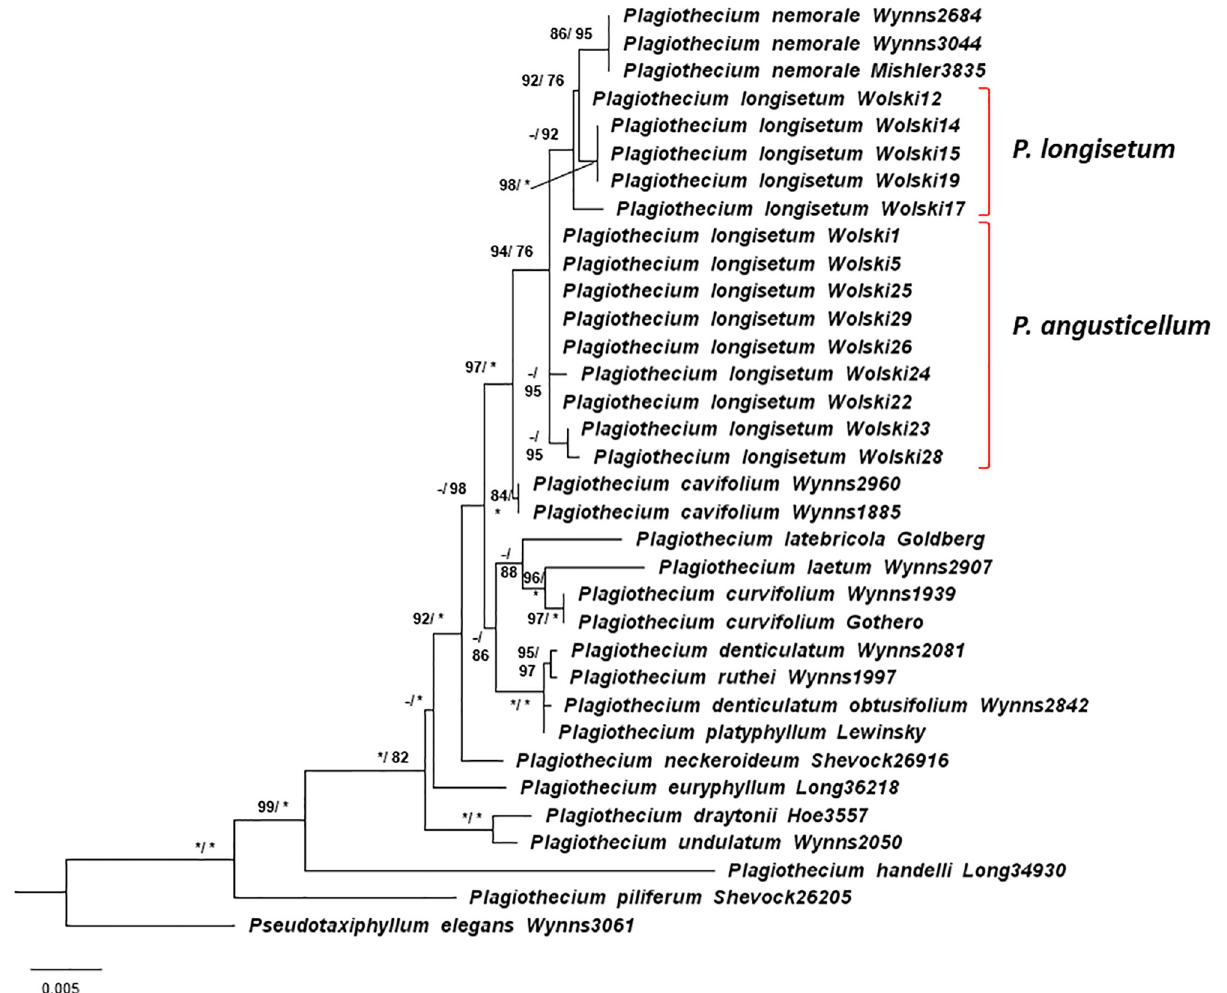
Fig 5. Phylogenetic tree of Plagiothecium group with Pseudotaxiphyllum as the outgroup taxa based on concatenated nuclear (ITS) and chloroplast ( rps4 and rpl16 ) DNA markers (total 2068 bp). The tree shows the position of P . longisetum specimens among the Plagiothecium group. Numbers on branches indicate bootstrap values from ML followed by posterior probabilities from BI analysis. Asterisk ( � ) indicates 100 (ML. MP) and 1.00 (BI), while minus (-) indicates values below 80 (ML) and 75 (BI). The topology of the tree was based on ML analysis.